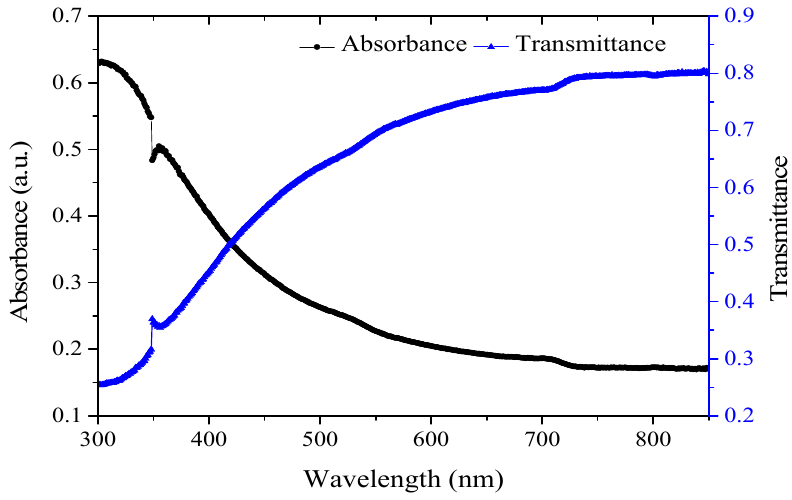
Figure 3. UV-VIS absorption and transmittance spectra of chitosan-PEG blend.